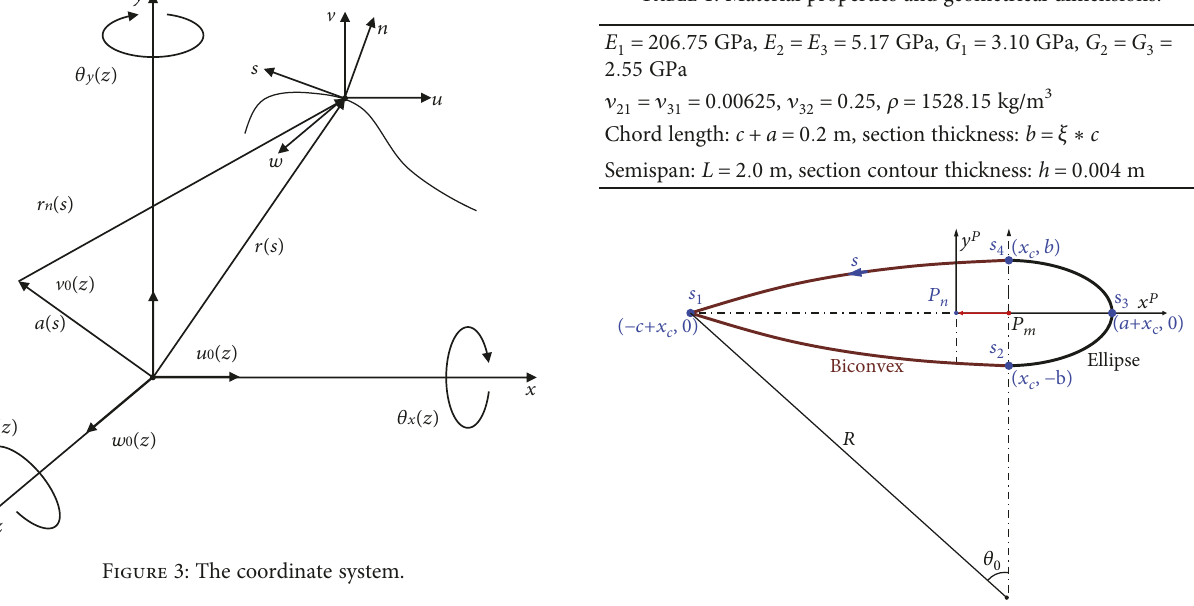
Figure 4: The translated geometrical parameters of the section (Model